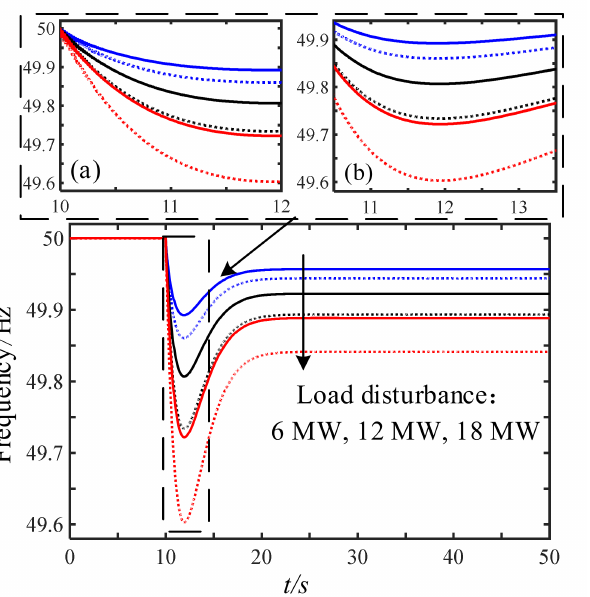
Figure 15. The influence with (solid line)/without (dashed line) asynchronous motors on the system frequency characteristics with increasing load disturbance when wind power is considered. ( a ) The maximum rate of change of frequency; ( b ) The maximum frequency